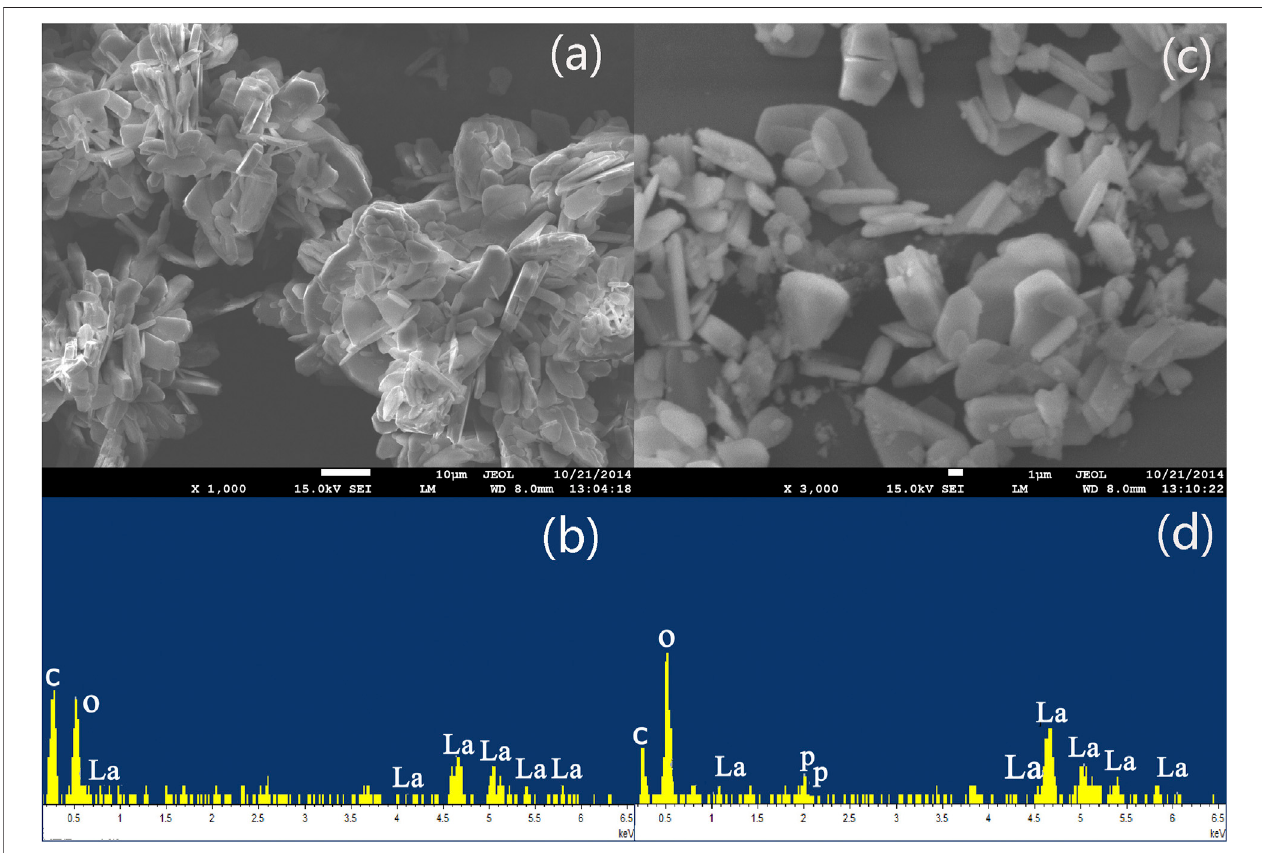
FIGURE 2 | SEM/EDS images of La 2 (CO 3 ) 3 (A,B) and La 2 (CO 3 ) 3 /PO 43 − (C,D) .